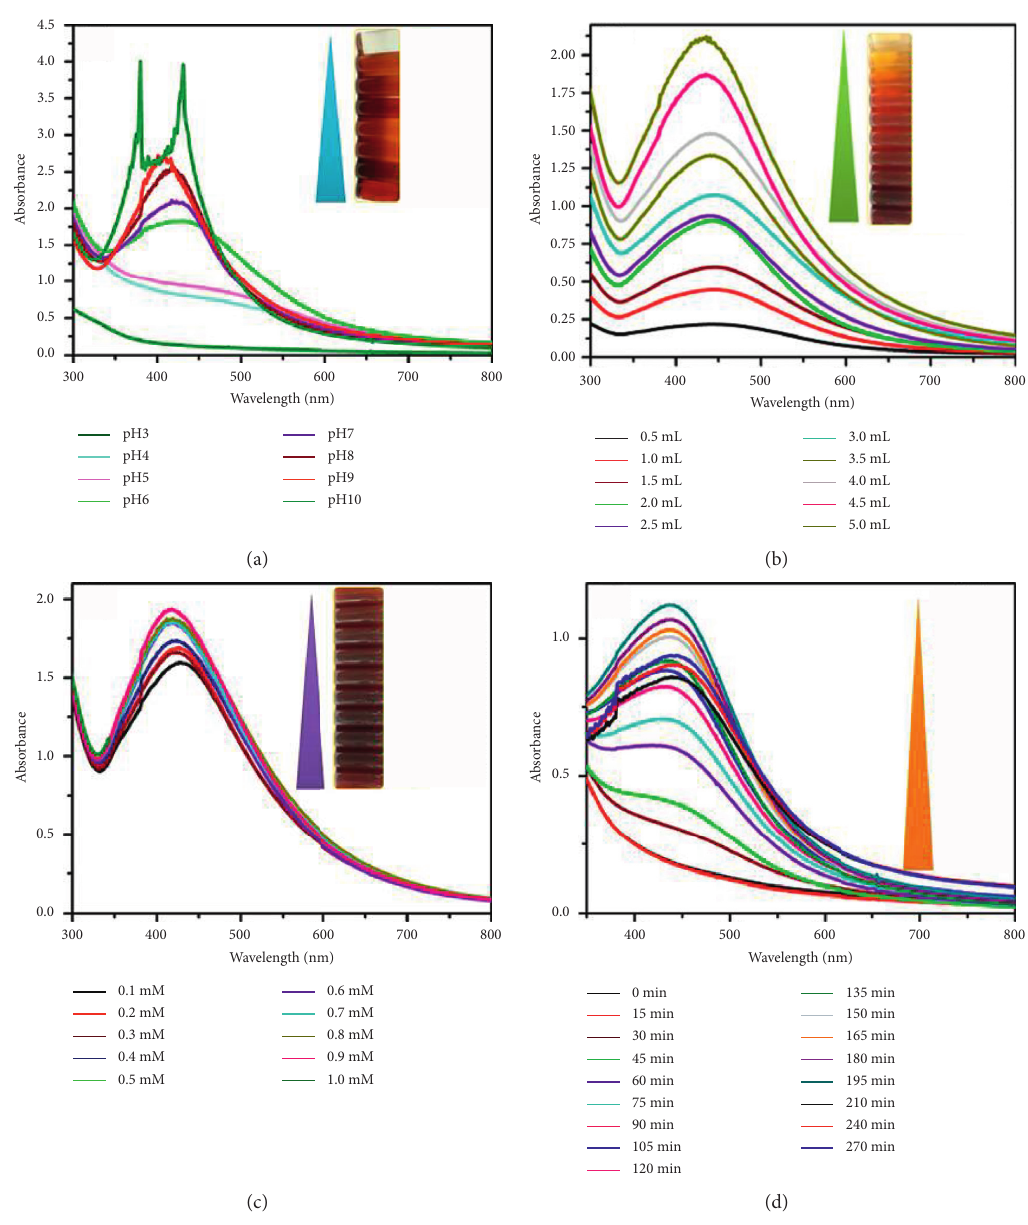
Figure 3: UV-Vis absorption spectra-optimization of parameters for the production of Ag 0.5 to 5mL (b), concentration of metal ions Ag + from 0.1 to 1.0mM (c), and different times from 0 to 270min (d)